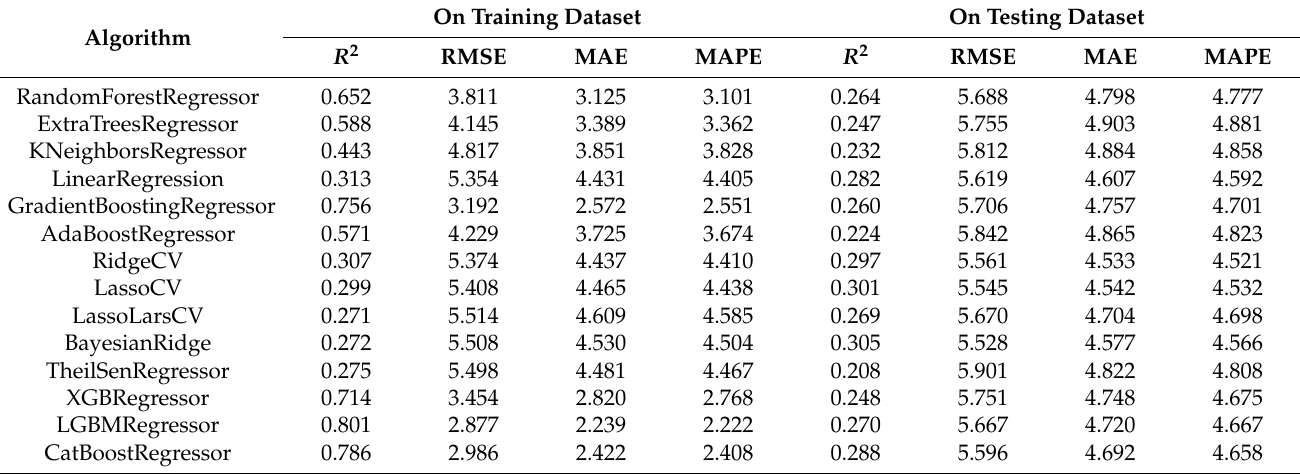
Table 3. Comparison of the model performances in terms of R 2 , RMSE, MAE, and MAPE.